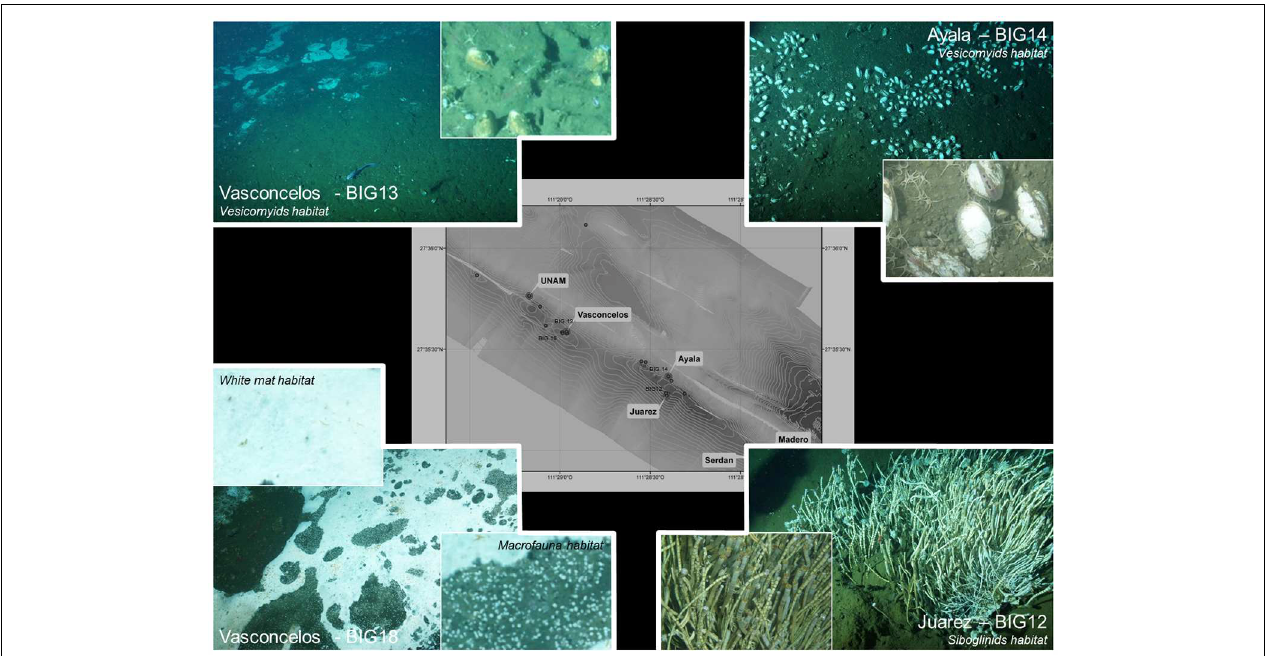
FIGURE 1 | Bathymetric map of the Sonora Margin and localization and pictures of the sampling